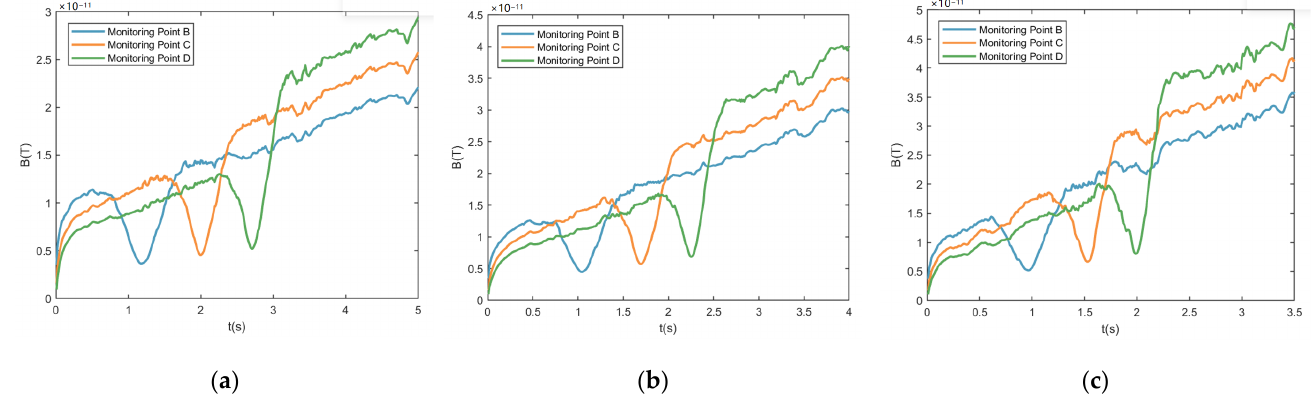
Figure 14. Magnetic field time domain diagrams at different monitoring points when the submarine moves with different accelerations. ( a ) a = 1 m/s 2 ; ( b ) a = 2 m/s 2 ; and ( c ) a = 3 m/s 2 .